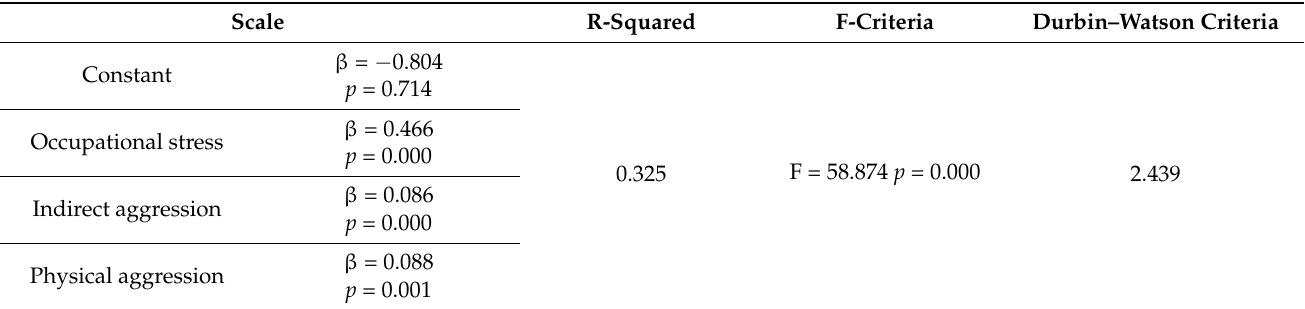
Table 10. Assessment of the contribution of occupational stress and aggression (indirect and physical) to the development of emotional exhaustion in COVID-19 ICU HCWs.